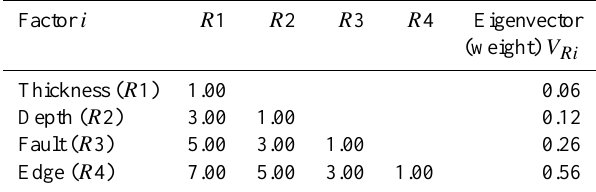
Table 3. Continuous rating scale for pairwise comparison of the Saaty method.